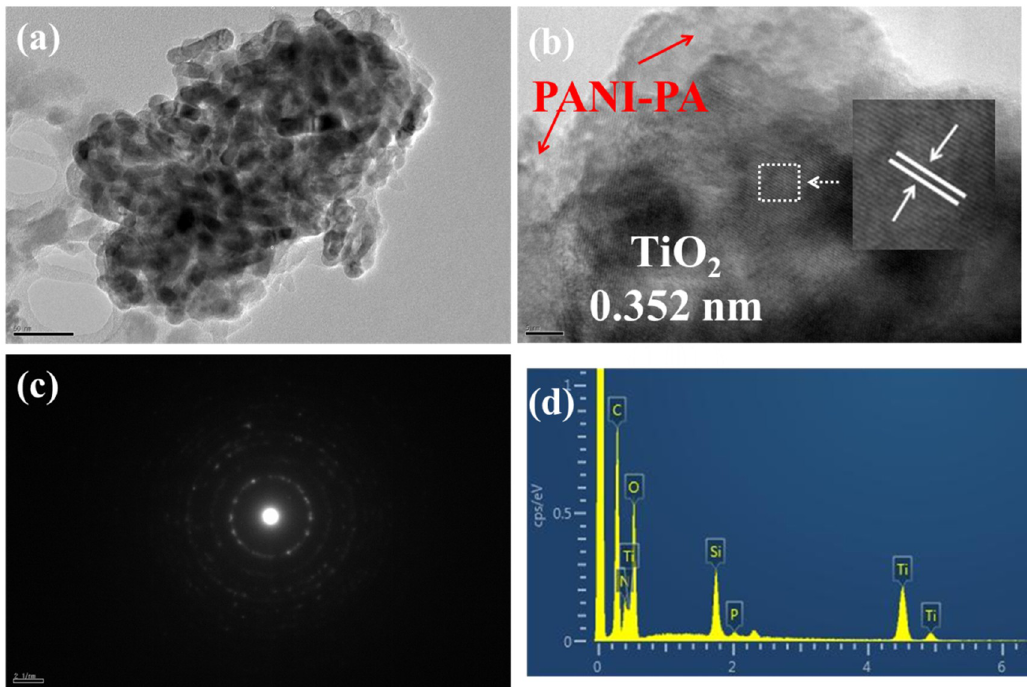
Figure 3. ( a ) TEM image of the TiO 2 @PANI product at m (TiO 2 )/m (Ani) = 2 and the scale is 50 nm in the lower-left corner; ( b ) HRTEM image of the product and the scale is 5 nm, and the insert picture is the enlarged picture of the lattice stripe of TiO 2 NPs; ( c ) the selected area electron diffraction and ( d ) the energy spectrum of the TiO 2 @PANI sample.